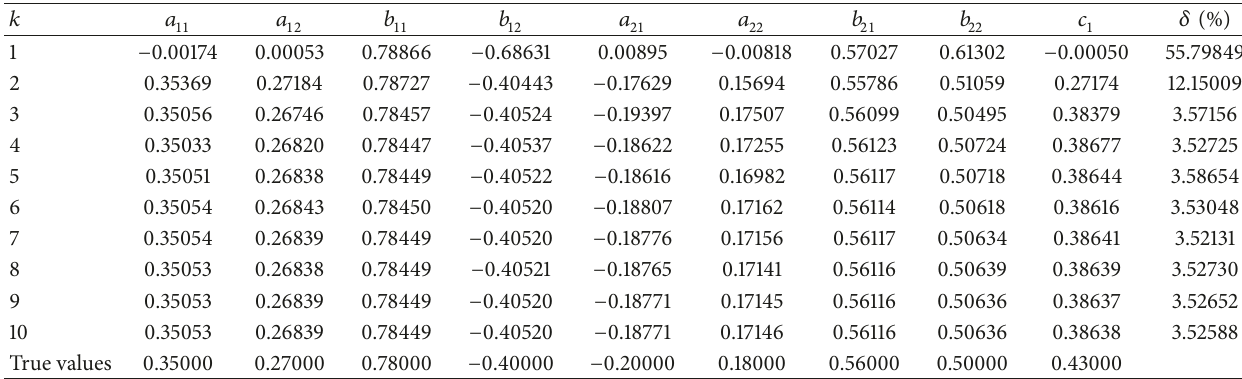
Table 1: The LSI parameter estimates and errors for Example 1.